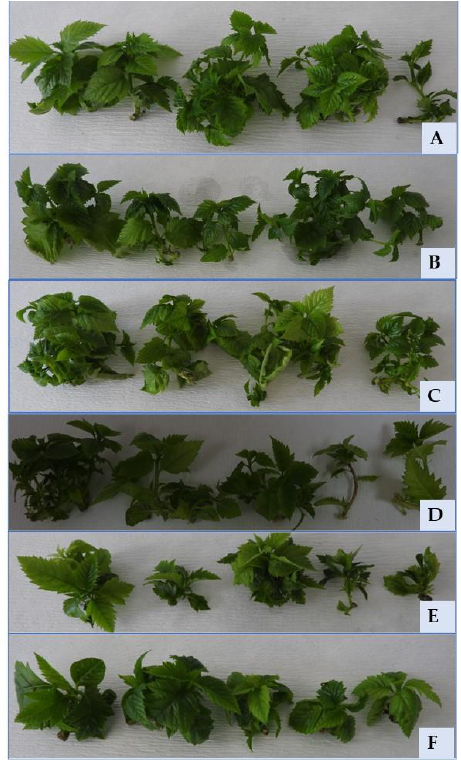
Figure 9. Four-week-old shoot cultures of Sorbus redliana ‘Burokvölgy’ developed during the first subculture after storage at 4 °CD for four weeks ( A ), at 4 °CD for 16 weeks ( B ), at 4 °CD for 36 weeks ( C ), at 4 °CD for 52 weeks ( D ), at 22 °CL for four weeks ( E ), and at 22 °CL for 16 weeks ( F ).